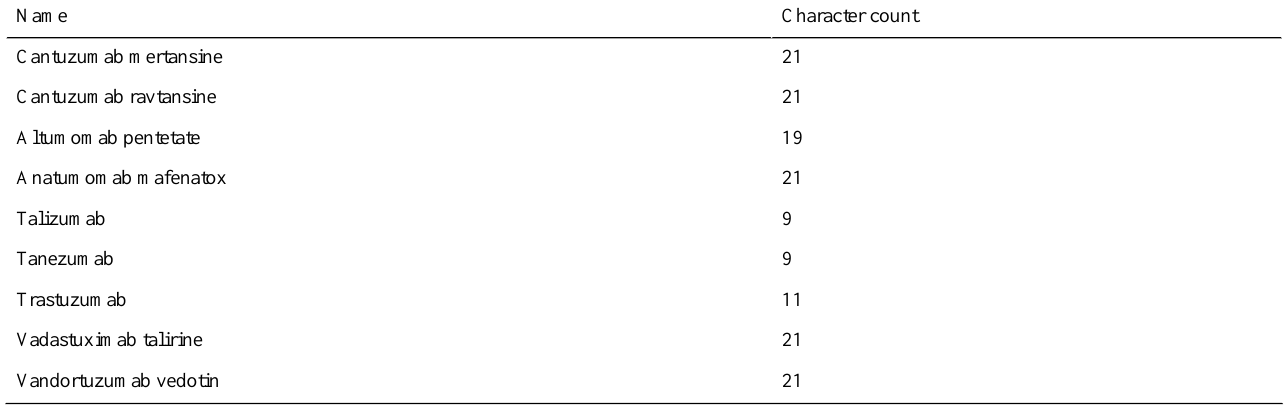
Table 7. Examples of monoclonal antibody medications currently in the market, with character